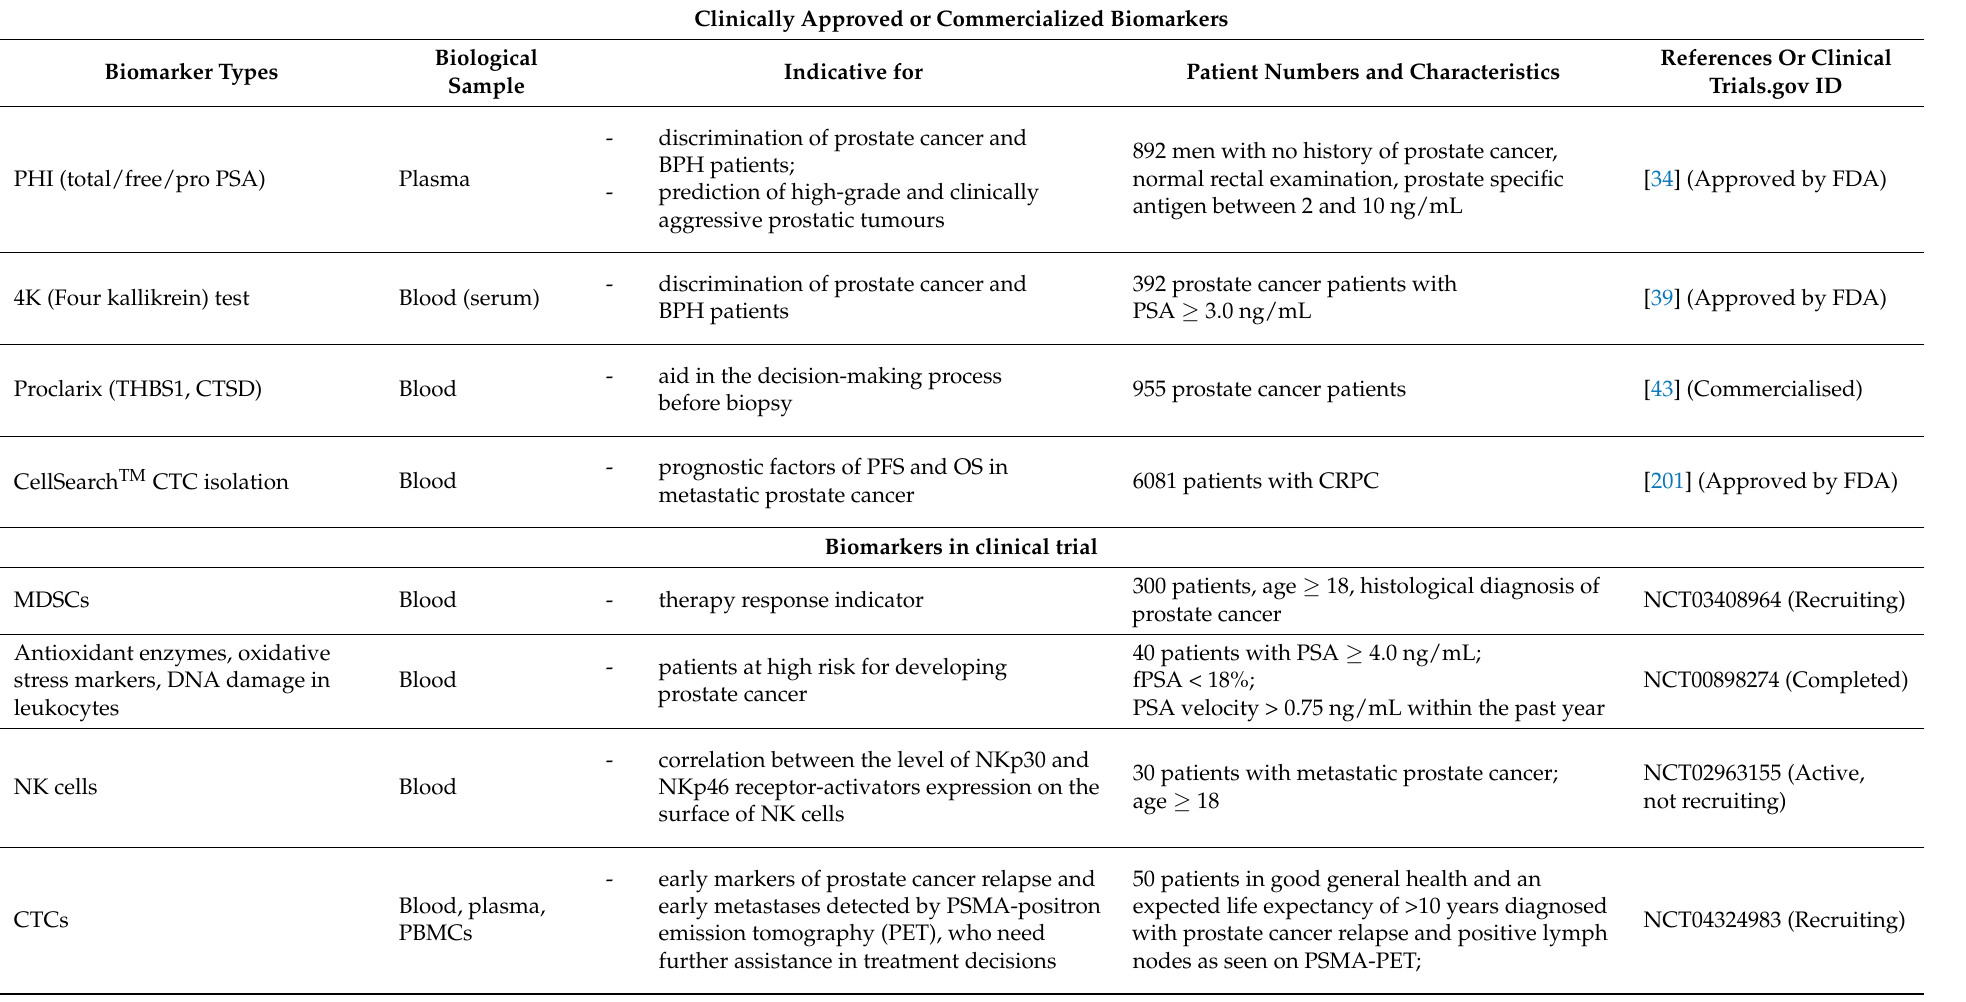
Table 1. Summary of representative human studies investigating blood-derived liquid biopsy markers as biomarkers in prostate cancer